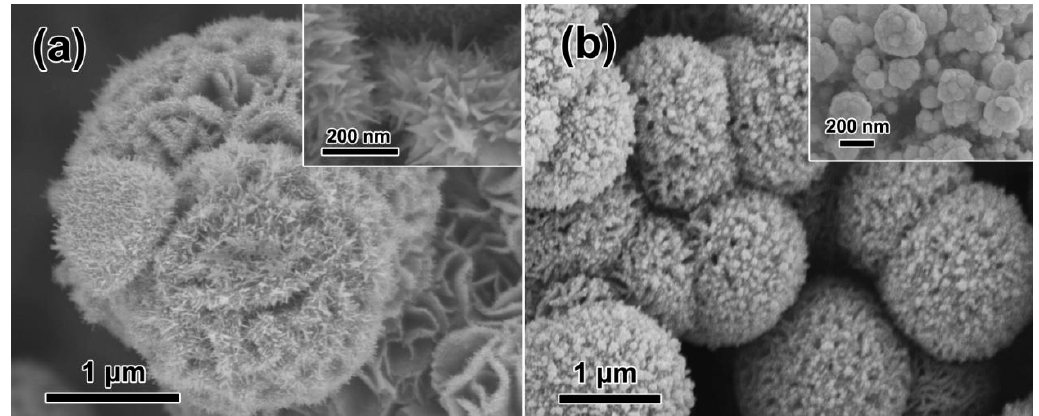
Figure 6. FE-SEM observations of the Au/CuS products obtained by adding 7.5 mL of HAuCl 4 solu- tion into 15 mL of Cu 2 S microflower suspension at different temperatures. ( a ) 5 °C and ( b ) 50 °C. The insets are the corresponding magnified images.